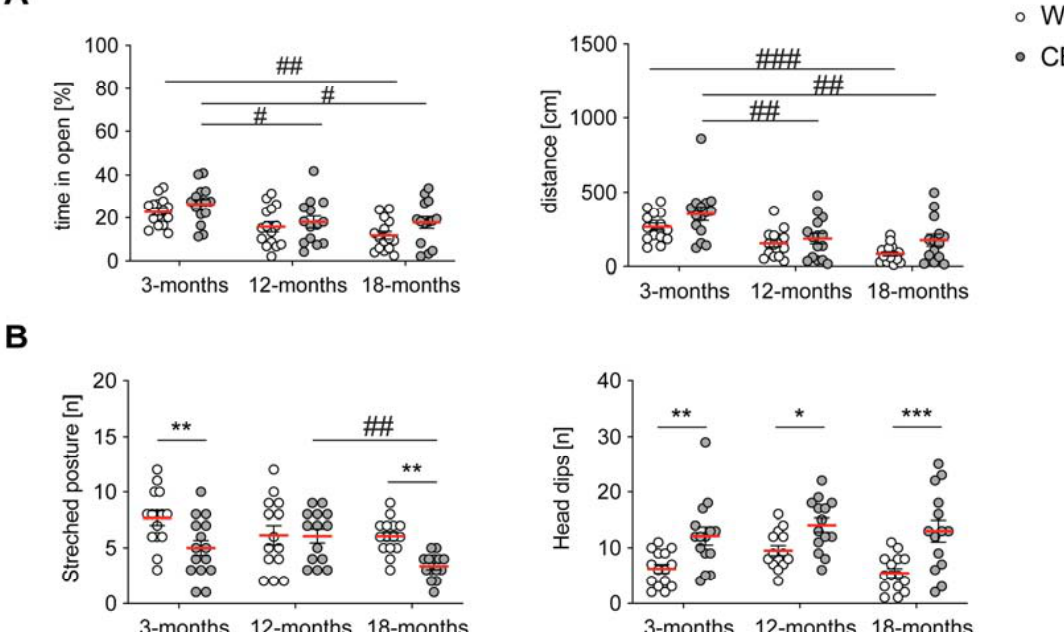
Figure 2. CB 2 R deletion results in a decreased anxiety phenotype in O-maze. ( A ) Left panel: % of time spent in the open compartment depended on the age and genotype of the mice. Decreased % of time indicates higher anxiety. Right panel: distance travelled in the open compartment depended on the age and genotype of the mice. Decreased distance indicates higher anxiety. ( B ) Left panel: number of stretched posture behaviors was dependent on genotype and age. Increased number of stretched postures indicates higher anxiety. Right panel: number of head dipping behaviors in the open compartment was increased in CB 2 R − / − mice independent of age. Decreased number of head dips indicates higher anxiety. WT mice—white circle; CB 2 R − / − mice—grey circles. N = 14–15 mice/genotype/age group. Each point represents a single mouse. Red line indicates the mean value ± SEM. Two-way ANOVA followed by Sidak’s multiple comparison test with * p < 0.05, ** p < 0.01, *** p < 0.001 significance between genotypes within the same age group; # p < 0.05, ## p < 0.01, ### p < 0.001 significance between age groups within the same